Question: What does this figure show? Answer in one sentence.
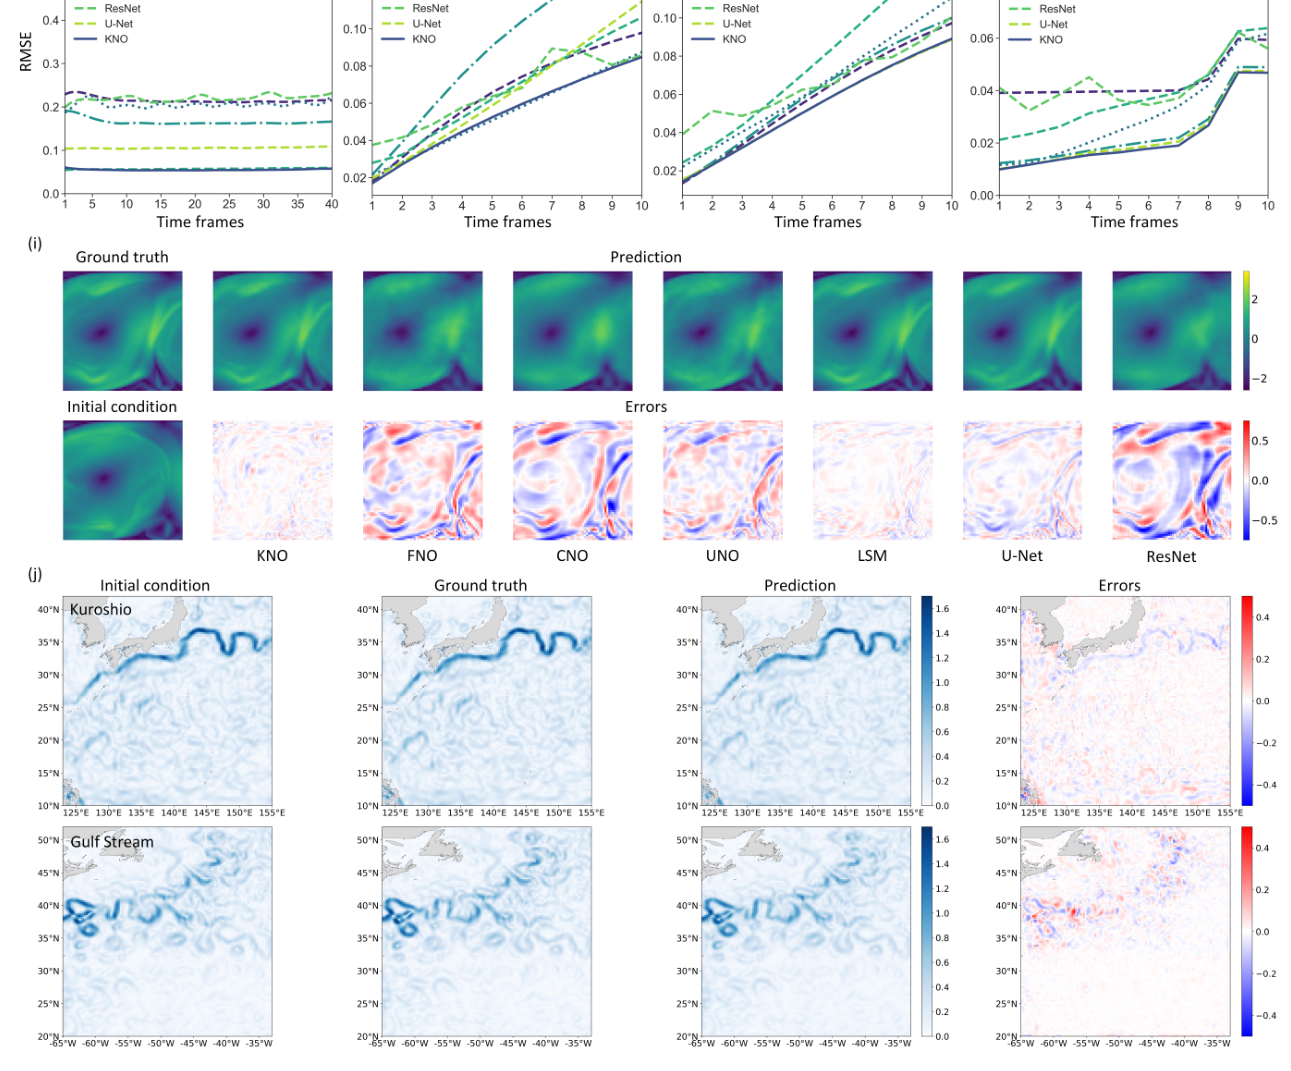
Answer: Experiment results of long-term prediction. (a-h) show the performances of all models on different data sets, where each prediction step creates a time frame. (i) visualizes the prediction results (the twenty-sixth time frame after the initial condition is selected as an instance for illustration) and the associated errors of all models on the Rayleigh-B´enard convection. Note that color bars in (i) are shared by all models. Therefore, the results can be directly compared across different models. (j) presents the prediction results (the third time frame after the initial condition) and the associated errors of the KNO on the Kuroshio and Gulf Stream currents.